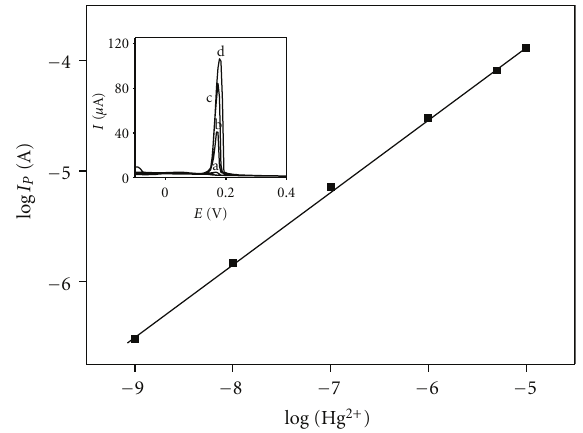
Figure 6: Calibration plot of log I p versus log [Hg 2+ ]. Inset figure: DPVs of di ff erent concentrations of Hg 2+ (a) 1.0 × 10 − 9 , (b) 1.0 × 10 − 8 , (c) 1.0 × 10 − 7 , (d) 1.0 × 10 − 6 mol L − 1 . The other conditions are same as in Figure 4.